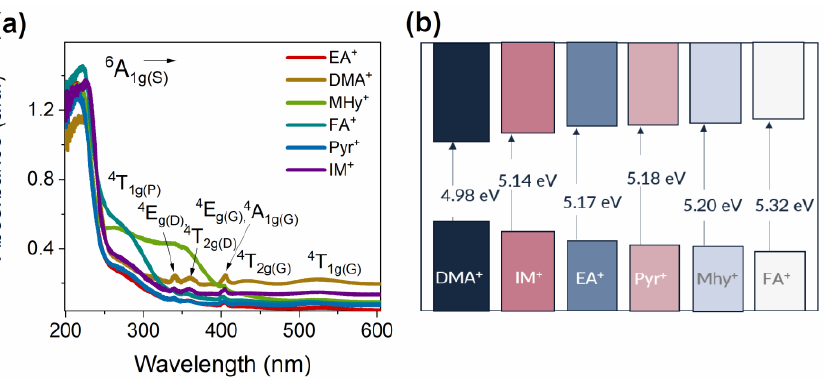
Figure 3. ( a ) Diffuse absorption spectra of the investigated samples and ( b ) scheme of the energy band gap estimated by the Kubelka–Munk function.